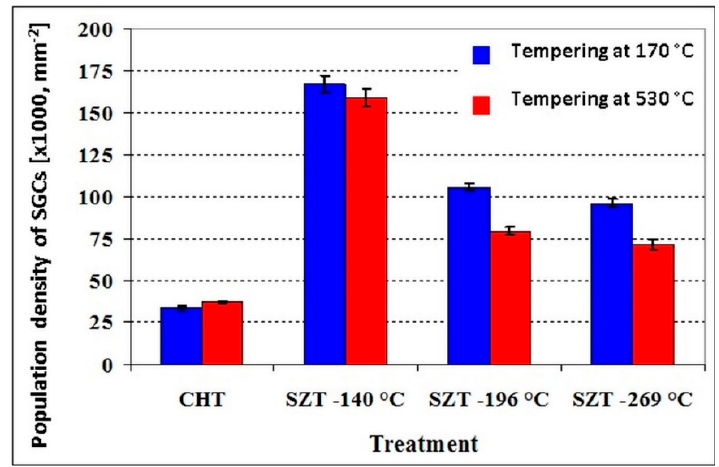
Figure 5. Population density of SGCs in CHT and different SZT specimens after tempering at 170 °C: ( a ) CHT, ( b ) SZT at − 140 °C, ( c ) SZT at − 196 °C, and ( d ) SZT at − 269 °C.